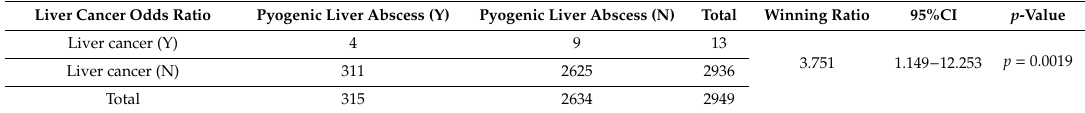
Table 6. Logistic regression liver cancer odds